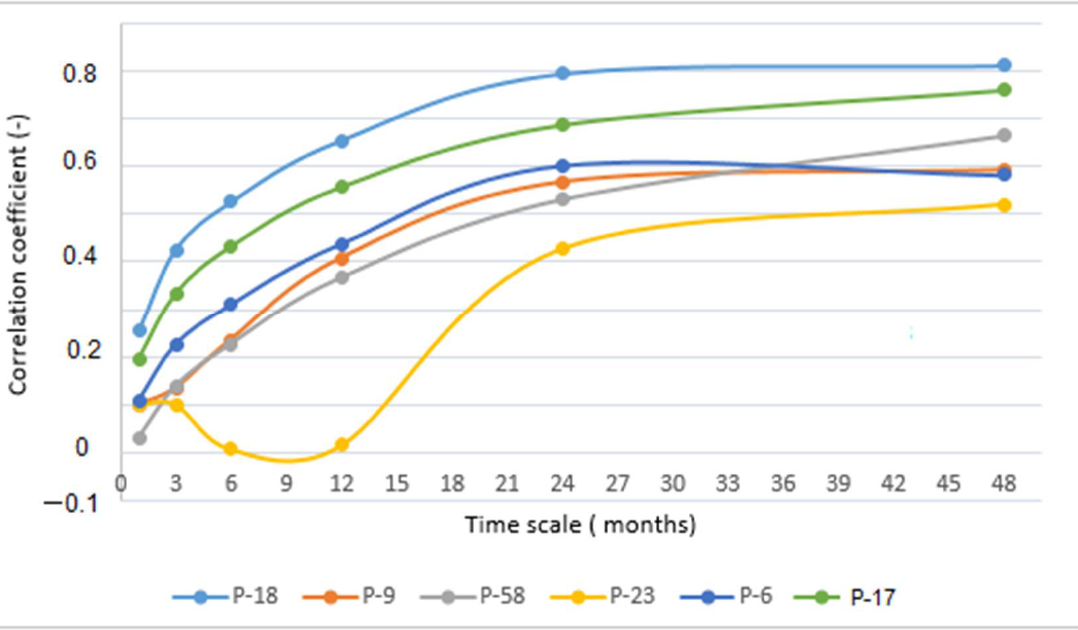
Figure 6. SPI/SGI correlation in different time scales for six observation wells. Calculated SGI was correlated to the SPI of the nearest meteorological station. The SPI/SGI correlation coefficients for most observation wells were continuously increasing